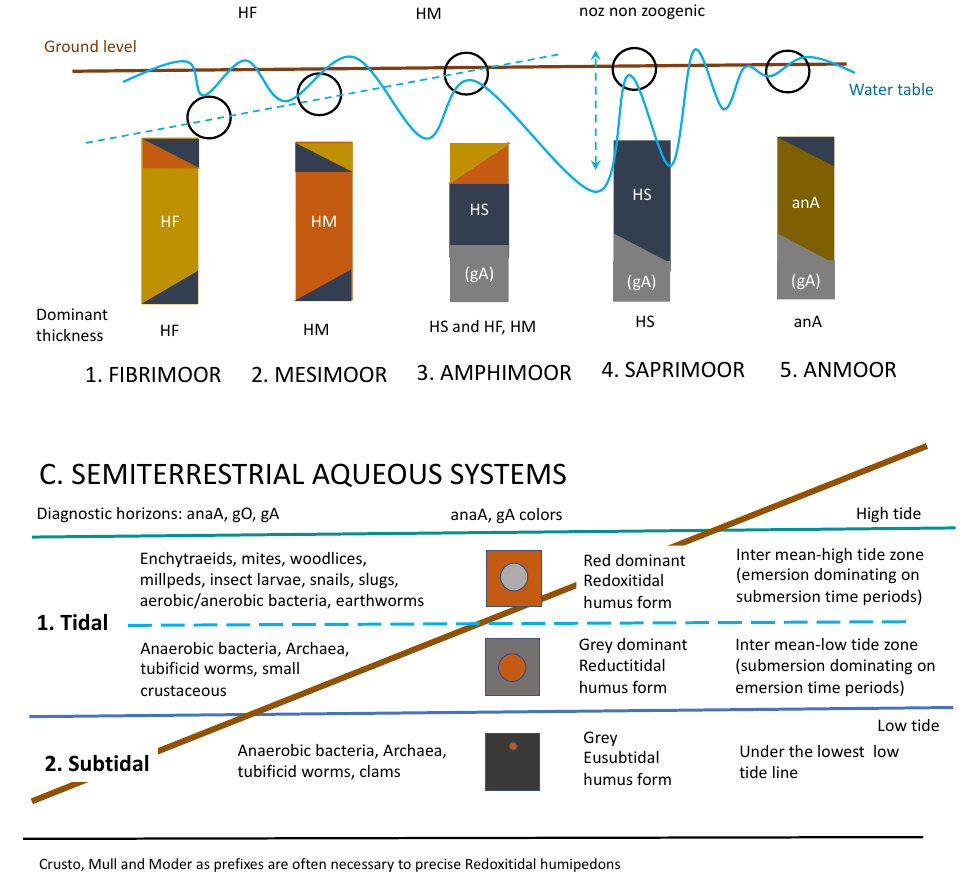
Figure 4. Schematizing the classification of Terrestrial ( A ), and Semiterrestrial Histic ( B ) or Aqueous ( C ) humus systems. Five morpho-functional systems are proposed for Terrestrial and Histic Semiterrestrial, and two of them for Aqueous Semiterrestrial.